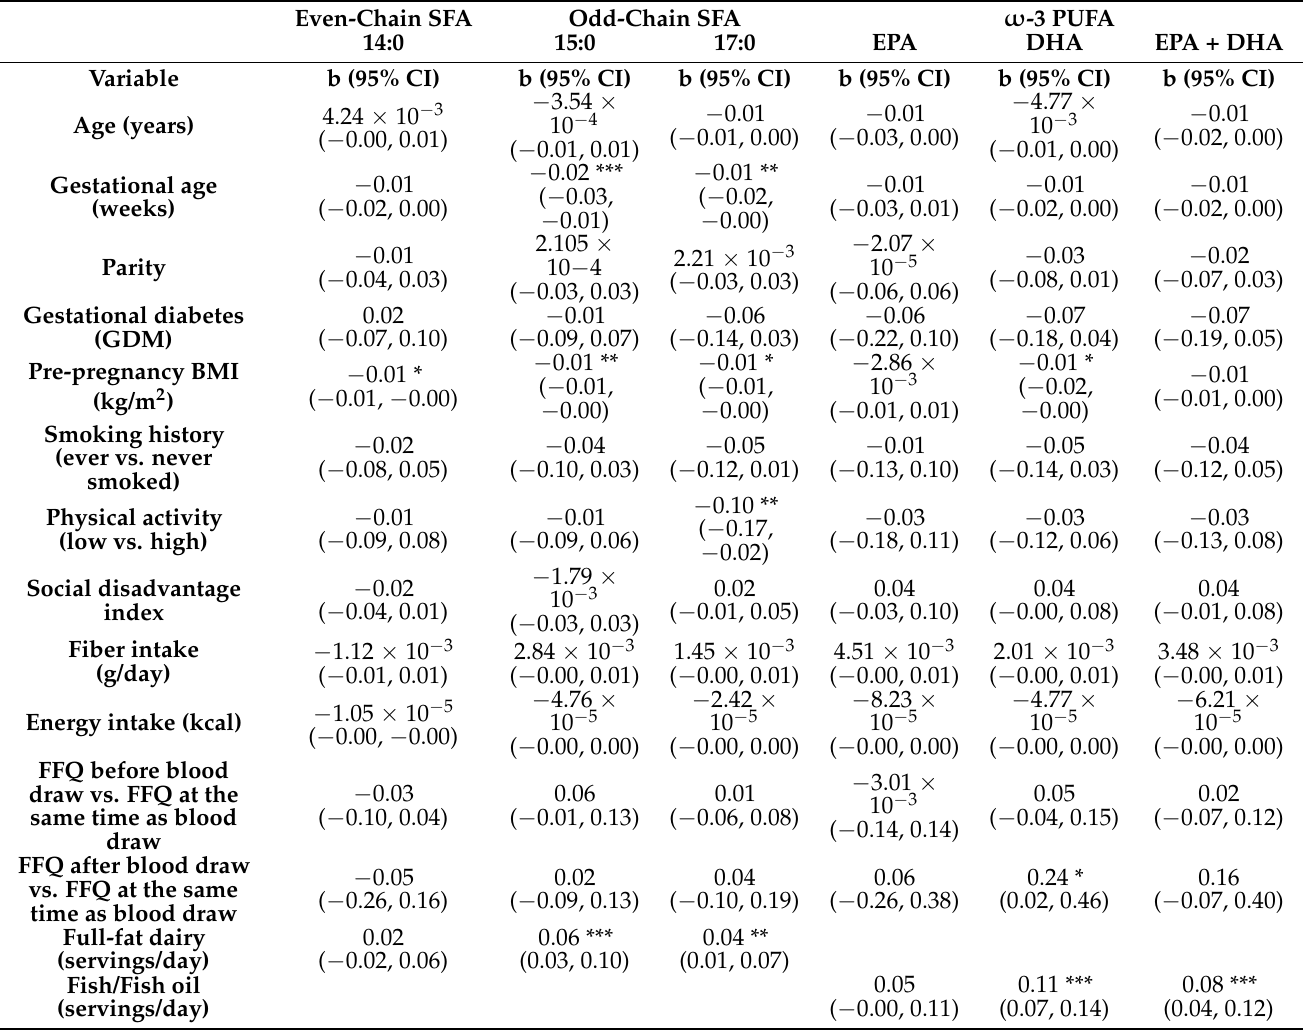
Table 3. Results from ordinary least squares regression examining the association of dietary and non-dietary factors with serum non-esterified fatty acid (NEFA) in the FAMILY cohort. Even-Chain SFA Odd-Chain SFA ω -3 PUFA 14:0